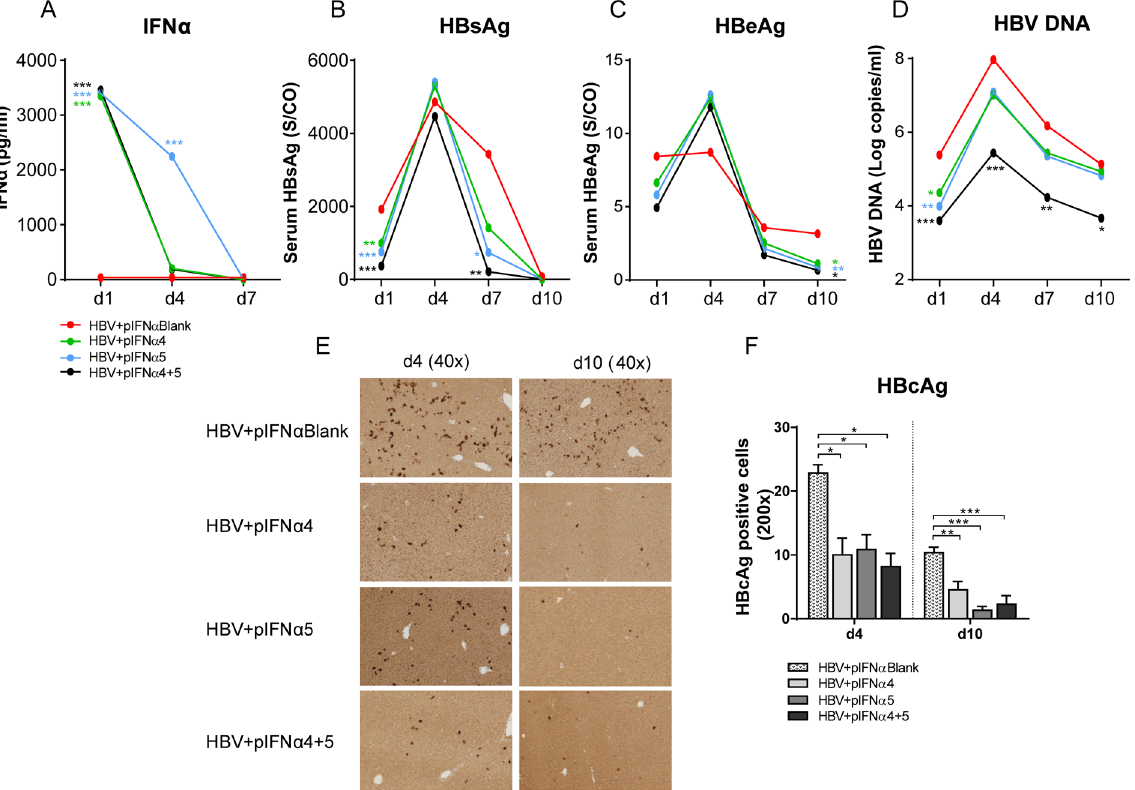
Figure 5. Kinetics of HBV replication in mice treated with plasmids encoding for different IFN α subtypes. Mice received HI with 10 µ g of pAAV-HBV1.2 plasmids in combination with 20 µ g of plasmids encoding for IFN α subtypes (pIFN α 4, pIFN α 5, pIFN α 4 + 5 or pIFN α Blank (empty vector)). Mouse sera were collected at the indicated time points. ( A ) IFN α protein levels, ( B ) HBsAg, ( C ) HBeAg and ( D ) qPCR detection of HBV DNA levels in the sera of mice after HI. At days 4 and 10 post HI, mice were sacrificed and livers were analyzed. Immunohistochemical stainings using anti-HBc antibodies ( E ) were performed and frequencies of HBcAg positive cells are shown ( F ). At least six mice per group were analyzed. The data were analyzed by One-way ANOVA. Statistically significant differences between the IFN-treated groups and the untreated control group are indicated by * for p < 0.05 ** for p < 0.01 and *** for p <